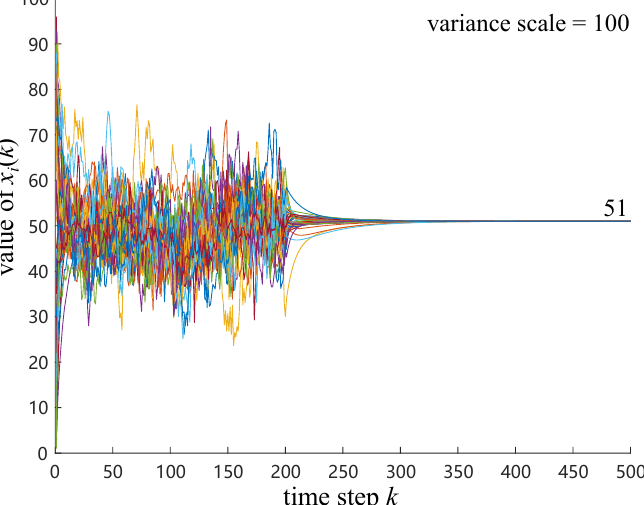
Figure 19. Manitara’s method under large variance.